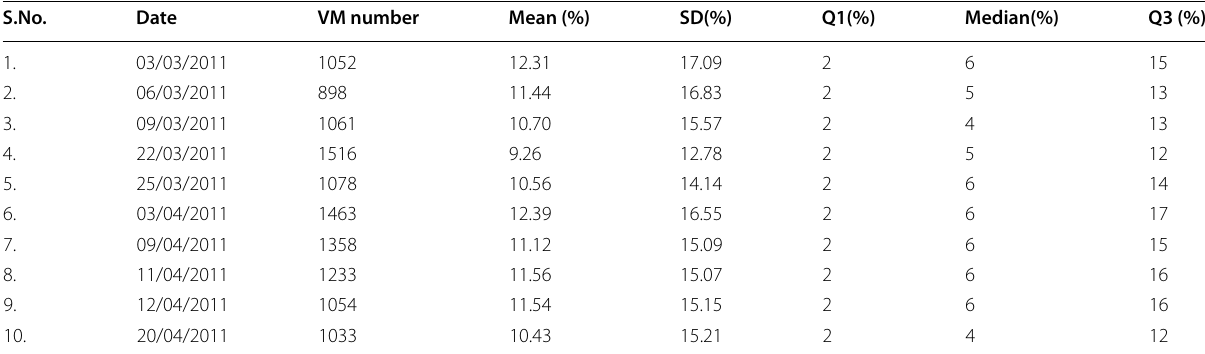
Table 9 PlanetLab Workload traces with statistical features [27]